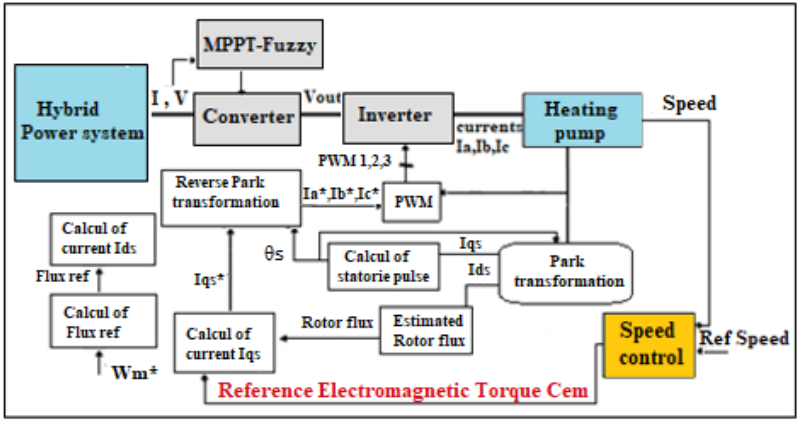
Figure 10. Scheme of the PI controller Optimized by Fuzzy Logic (PIOFL).